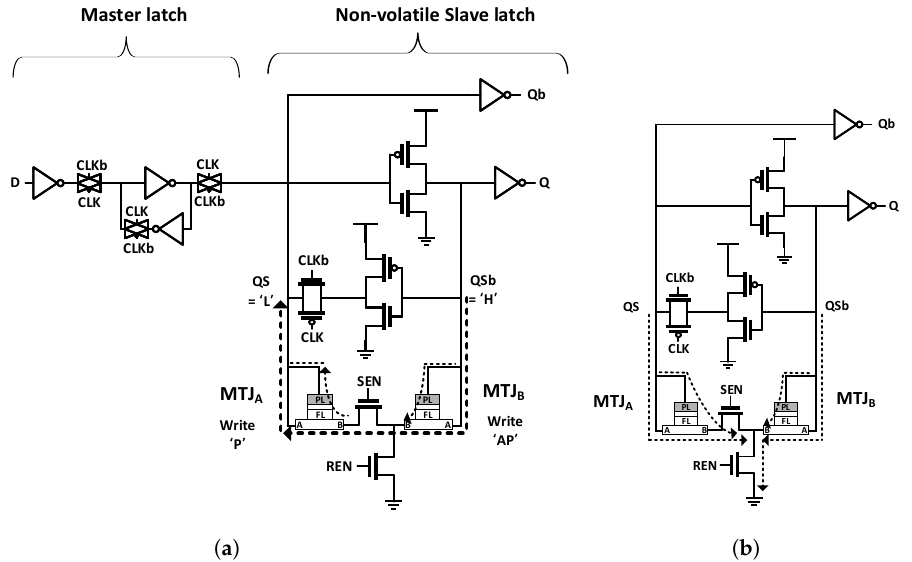
Figure 5. Schematic of the proposed SLS NVFF: ( a ) Storing operation (Q = 0), ( b ) Restoring operation (slave latch only).